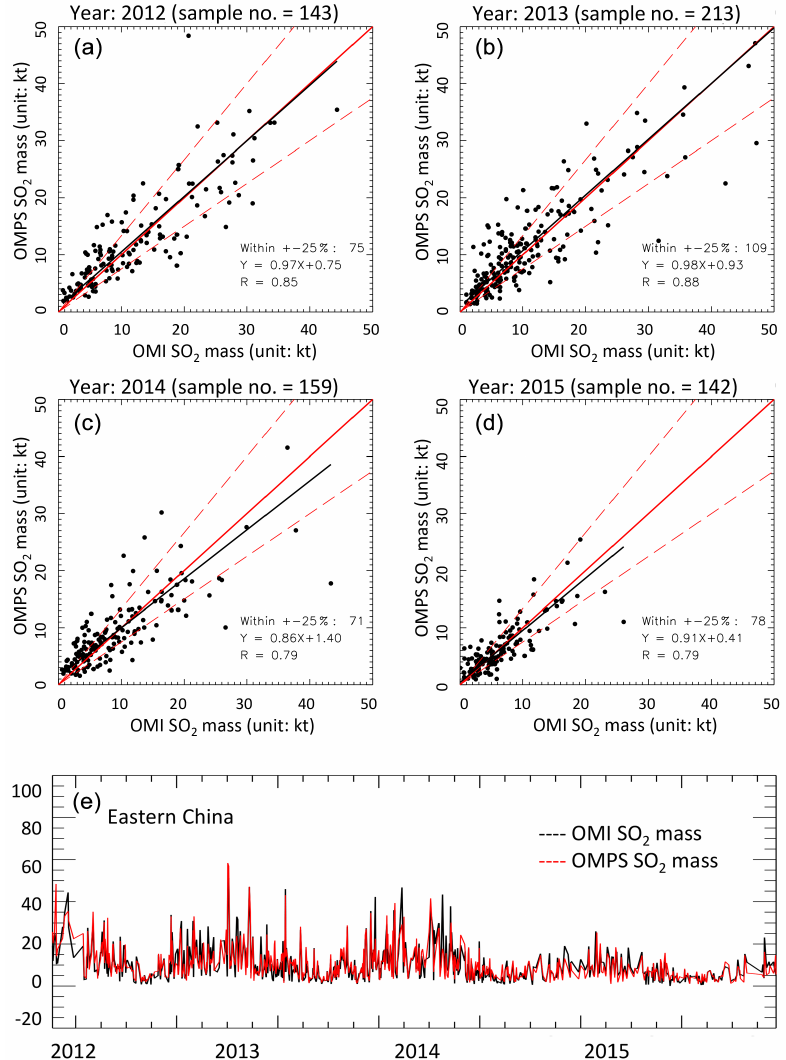
Figure 3. (a–d) Eastern China regional daily SO 2 mass (unit: kt) for OMI and OMPS for the years 2012, 2013, 2014, and 2015. Red solid line is the 1:1 line and dashed lines are ± 25%. Black line is the reduced major axis fitting of OMI and OMPS SO 2 masses. r is the temporal correlation coefficient. The number of samples within ± 25% is also presented here. (e) Time series of daily SO 2 mass in the eastern China region from 2012 to 2015 with valid data for both OMI and